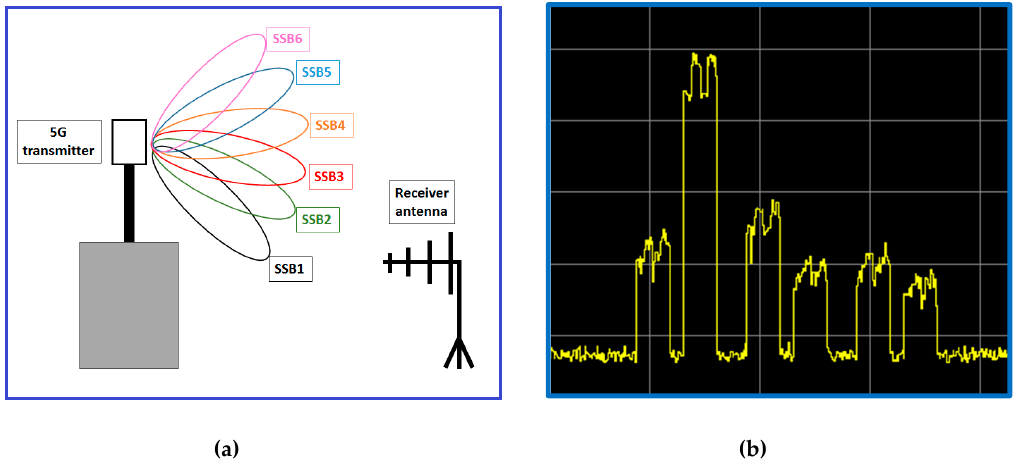
Figure 3. Beam sweeping synthesized by a 5G active antenna ( a ) and zero span measurement of the Synchronization Signal Blocks (SSBs) received power level ( b ). The received power is not constant in time, since each SSB is transmitted from a specific beam during a dedicated time slot. A detailed explanation on the SSBs is discussed in [7].